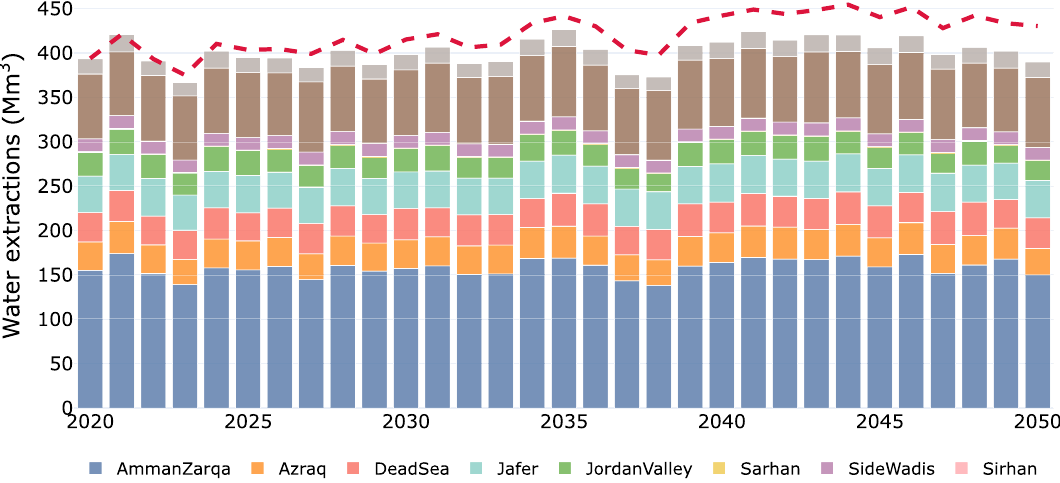
Fig. 6 Groundwater extractions in the No intervention scenarios, under two climate futures. Historical climate is represented by the bars and Increased Evapotranspiration by the dashed